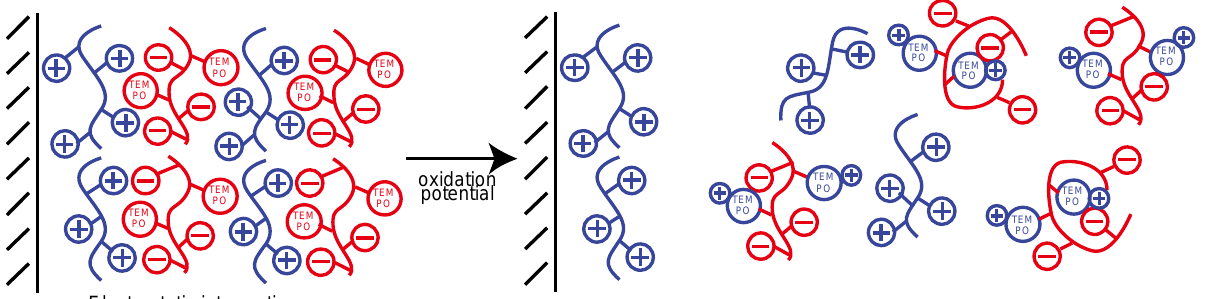
Figure 2. Response of TEMPO-PAA and polycations to electrical-stimulation. Schematic depiction of the molecular and conformational responses of polyelectrolytes bearing either basic, acid, or TEMPO moieties with respect to electrical-stimuli.